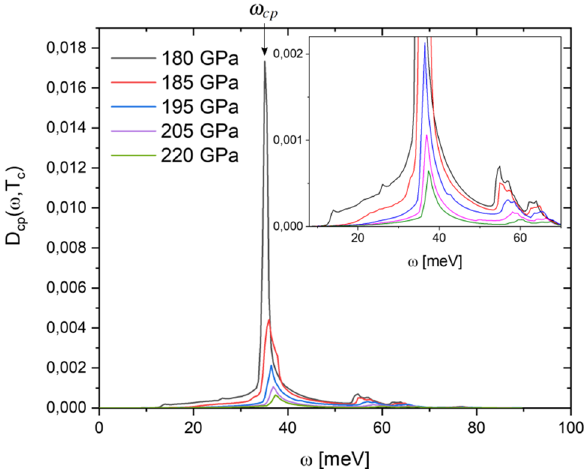
Figure 1. Cooper-pair distribution function D cp (ω , T c ) of D 3 S calculated at different pressures. The inset presents a zoom-in view of D cp (ω , T c ) from 10 to 70 meV.